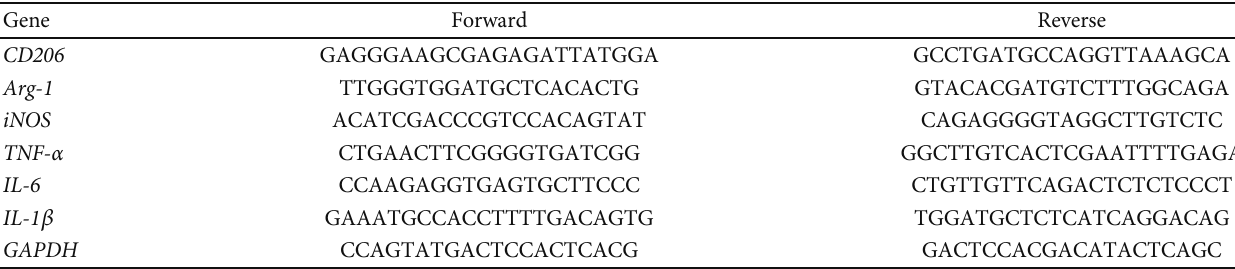
Table 1: Primer sequences used for